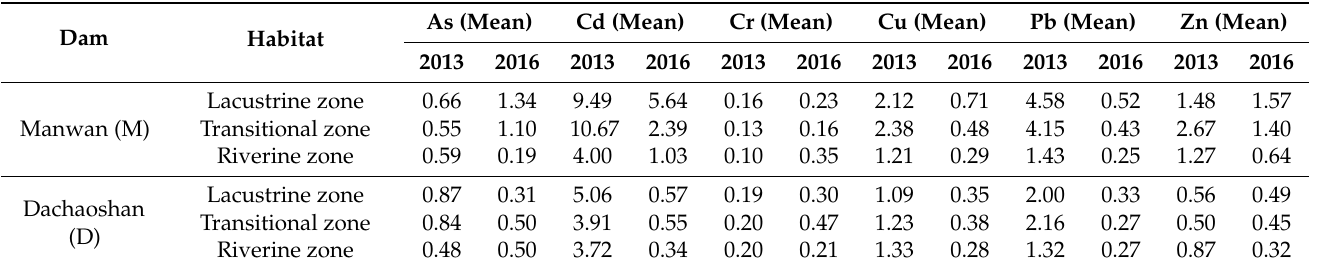
Table 3. Ratio of secondary phase and primary phase (RSP) variations of heavy metals in Manwan (M) and Dachaoshan (D) cascading